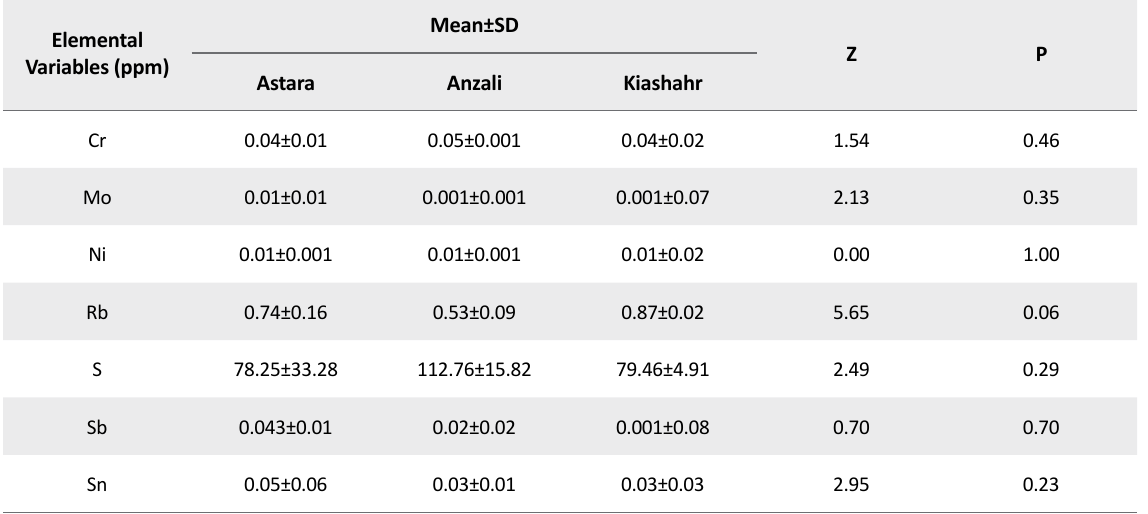
Table 3. Elemental concentrations of the fish skin in three different stations in the Caspian Sea, Iran Mean±SD Elemental Variables (ppm) Astara